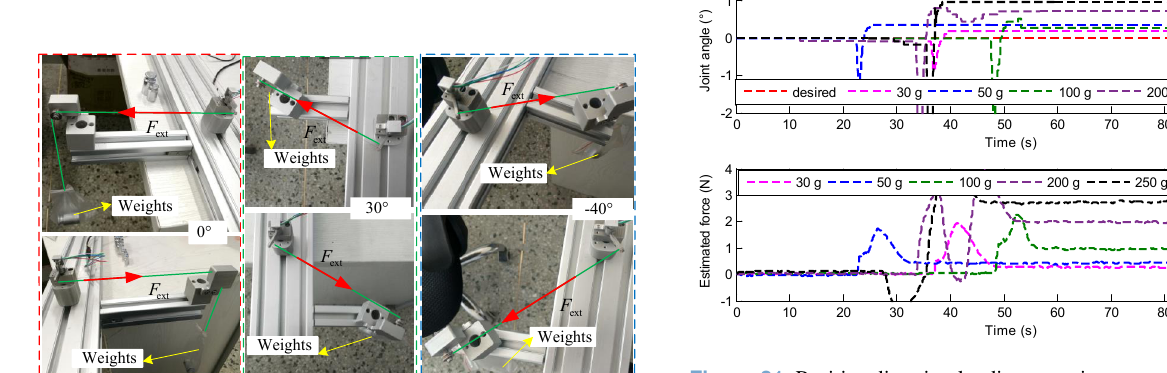
Figure 18. The verification result of the simplified model C.